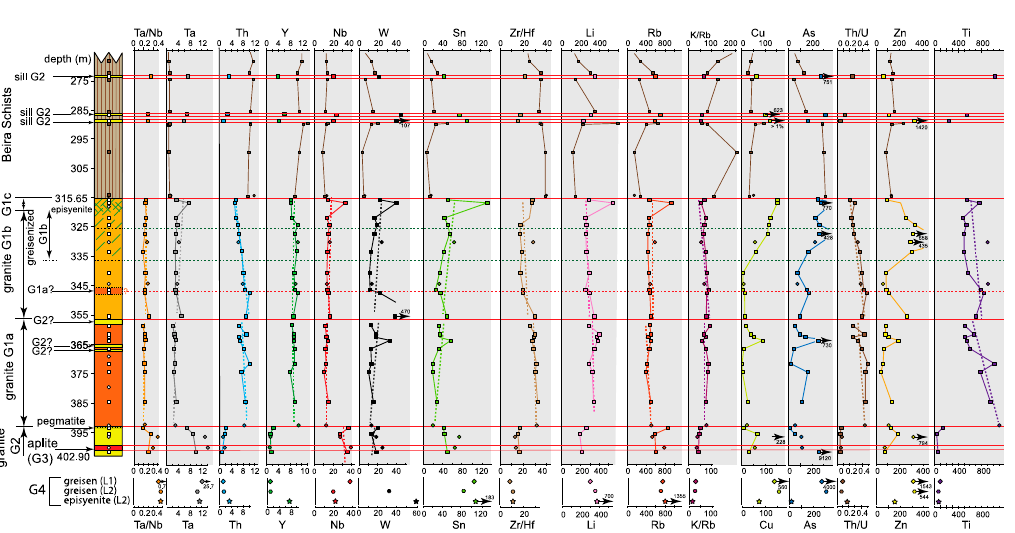
Figure 27. The SCB2 drill hole: trace element profiles. Data come from [16,17]; comparison with the G4 cupola composition: data from [18,56] (Table S5).